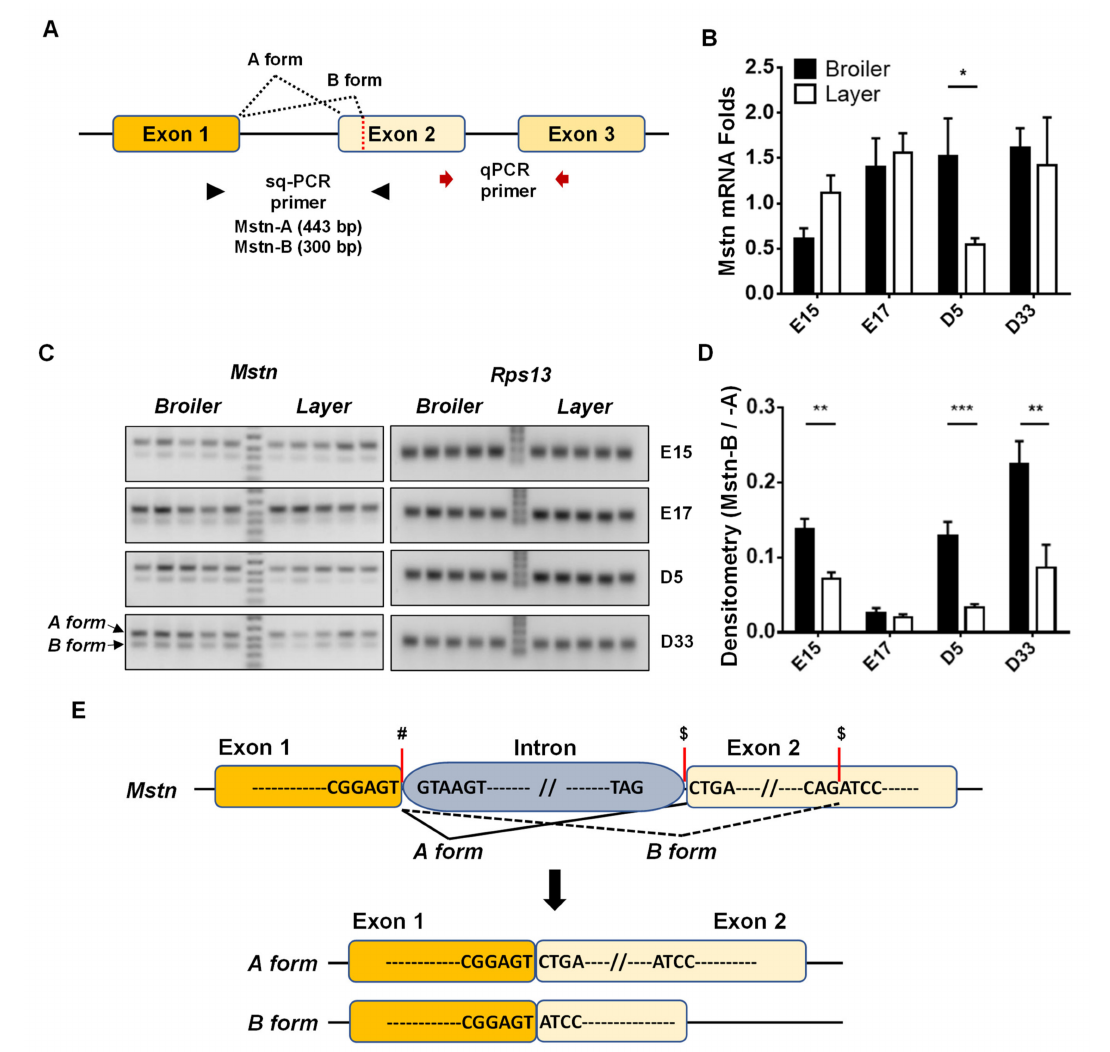
Figure 1. Comparisons of the expression levels of myostatin ( Mstn ) isoforms in broiler and layer chickens. ( A ). The schematic diagram shows the location of specific primer sets for qPCR and sqPCR of the chicken Mstn gene. ( B ). Quantitative analysis of the Mstn expression levels during development by qPCR (n = 5). ( C , D ). Gel electrophoresis of sqPCR products of Mstn and densitometry analyses. sqPCR products were separated by gel electrophoresis and the densitometry analyses (ratios of Mstn-B form to Mstn-A form) were performed using NIH ImageJ software. Rps13 was used as an internal control for qPCR and sqPCR. The multiple t -test was used for statistical analysis of the broiler and layer chickens by the Graphpad PRISM 6.02 program. The values presented are means ± SEM (n = 5). *: p < 0.05, **: p < 0.01 and ***: p < 0.001. Abbreviations: E, embryonic day; D, postnatal